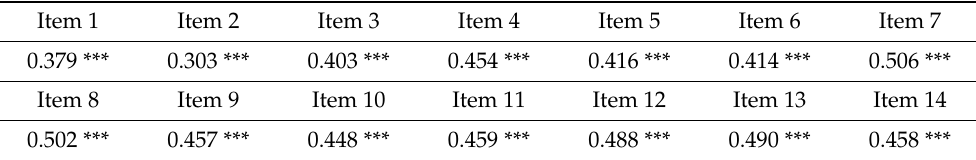
Table 2. Loevinger’s H value of 14